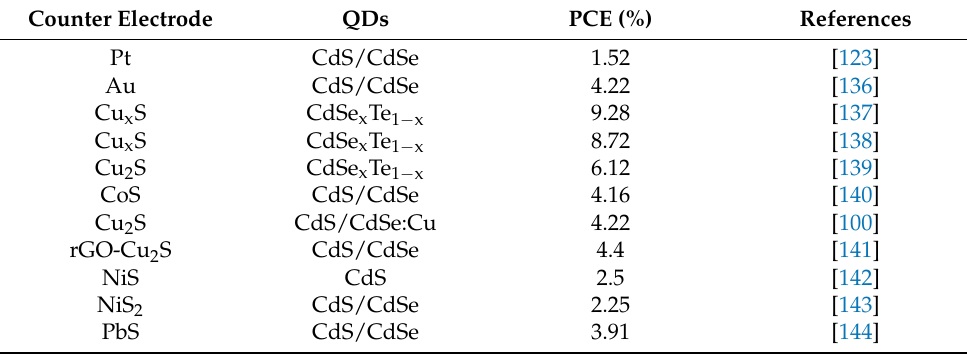
Table 4. Review on QDSSCS based on different counter electrodes.